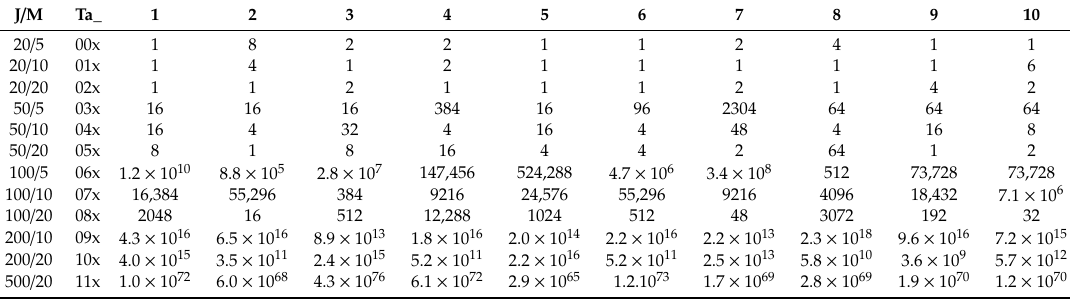
Table 2. Possible orders of Taillard’s benchmark after jobs ranking in the NEH heuristic. J / M